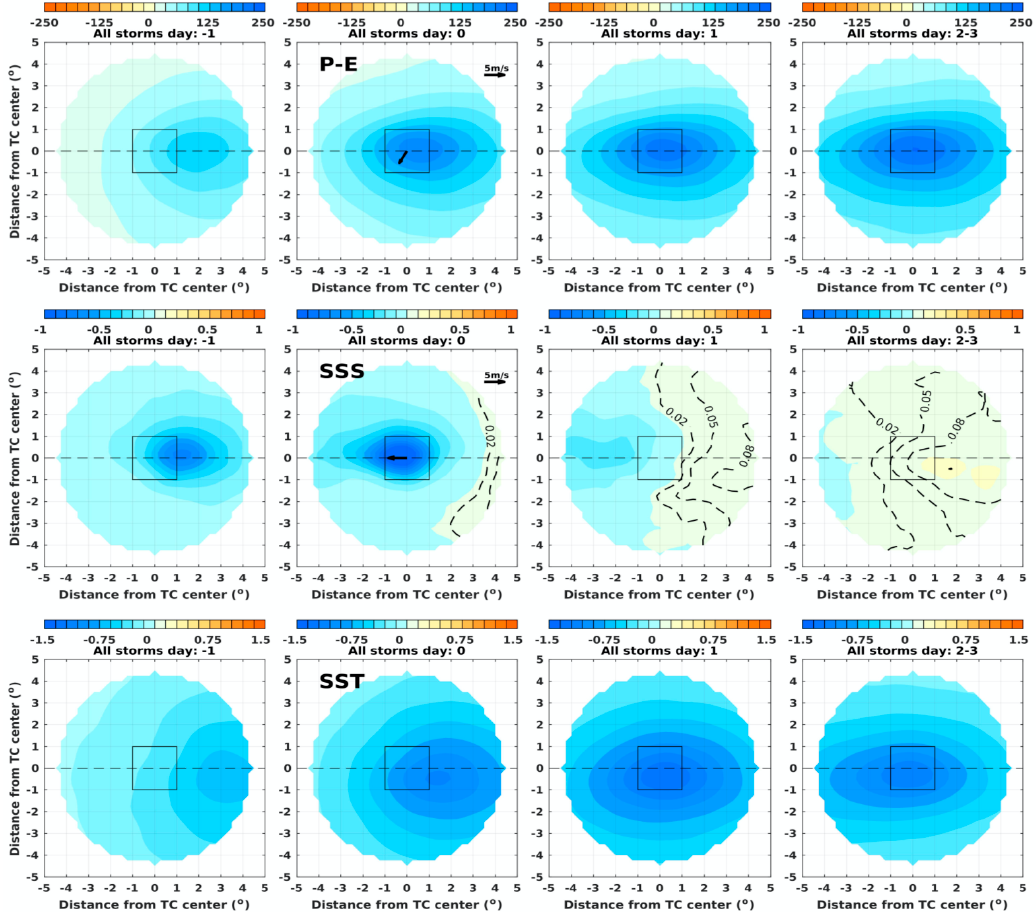
Figure 5. The same as Figure 4, but in the Southern Hemisphere. The composite vertical wind shear in upper panel day 0 is 3.32 m s − 1 . The composite translation speed in middle panel day 0 is 4.23 m s − 1